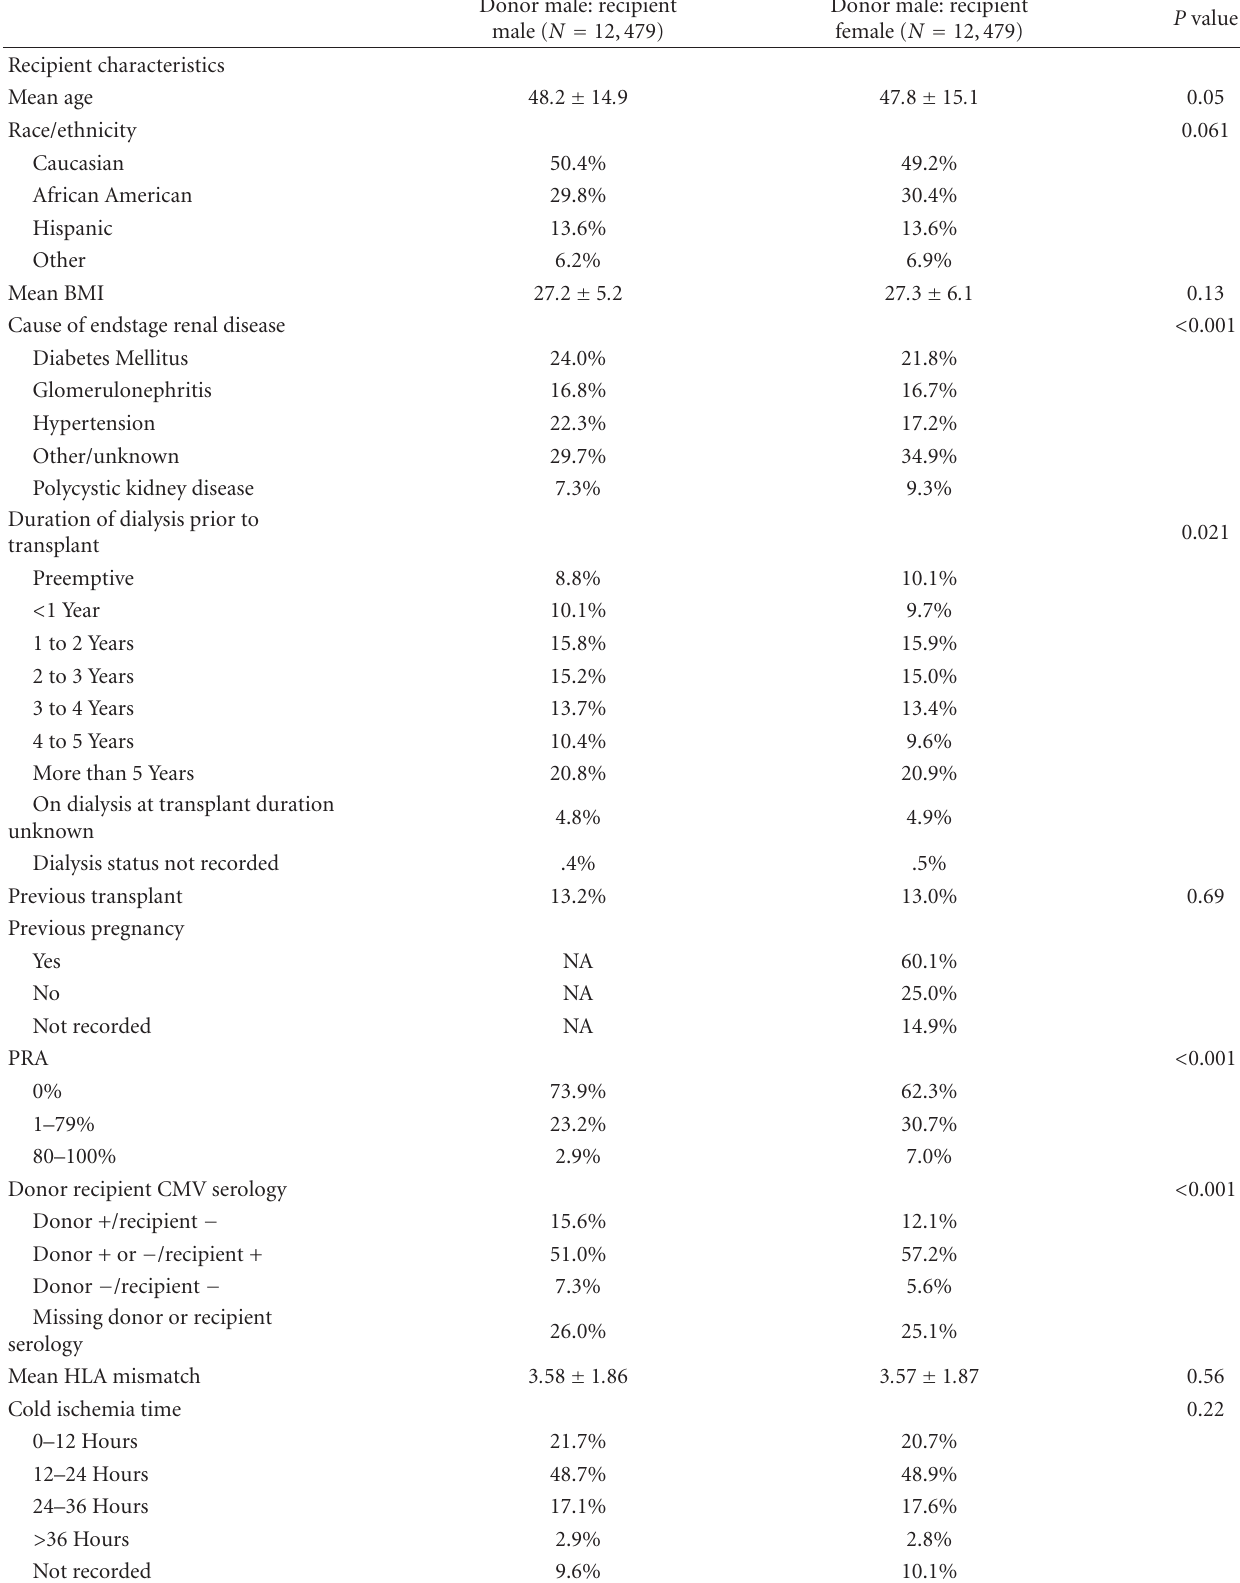
Table 1: Patient